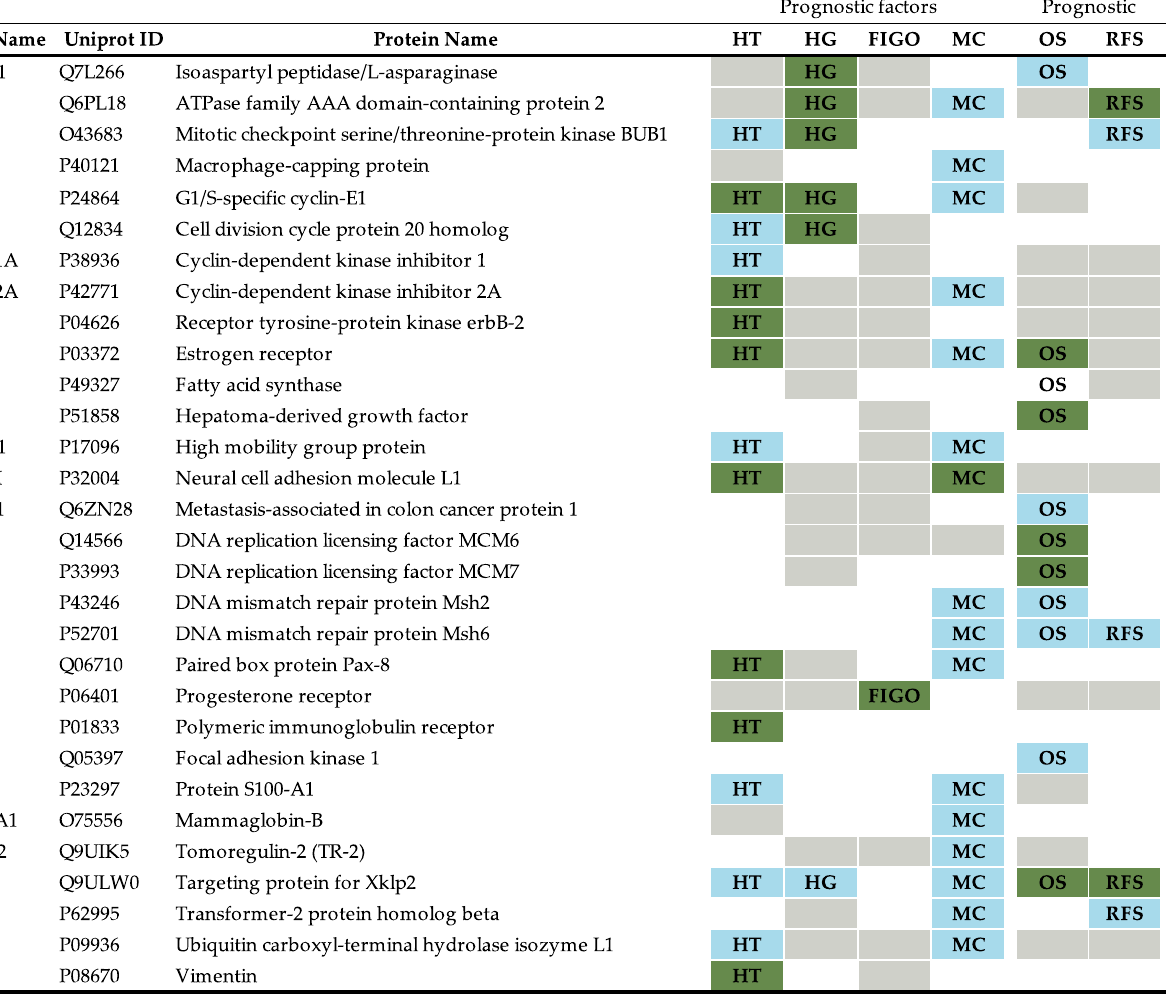
Figure 2. Summary for the 30 validated biomarkers in the analysis. Prognostic factors or prognostic value described in Coll-de la Rubia E et al., 2020 for each of these biomarkers [15] are highlighted in grey. Additionally, the specific prognostic factor or prognostic value validated in our analysis are indicated for each protein. The color green represents prognostic factors found in both: literature revision and statistical analysis, whereas the color blue represents new prognostic features not described before in literature. HT: histological type; HG: histological grade; FIGO: FIGO stage; MC: molecular classification defined by The Cancer Genome Atlas Network; OS: overall survival; RFS: recurrence-free survival.